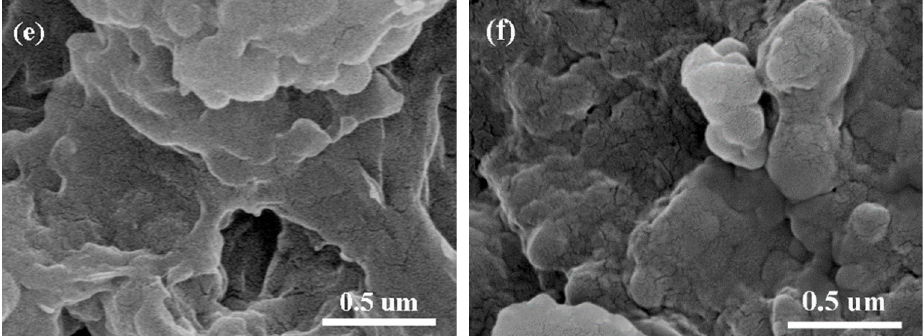
Figure 2. TEM images of PDAMs ( a , b ), SEM image of PDAMs ( c ), PEG/PDAM-1 ( d ), PEG/PDAM-2 ( e ), and PEG/PDAM-3 ( f ).